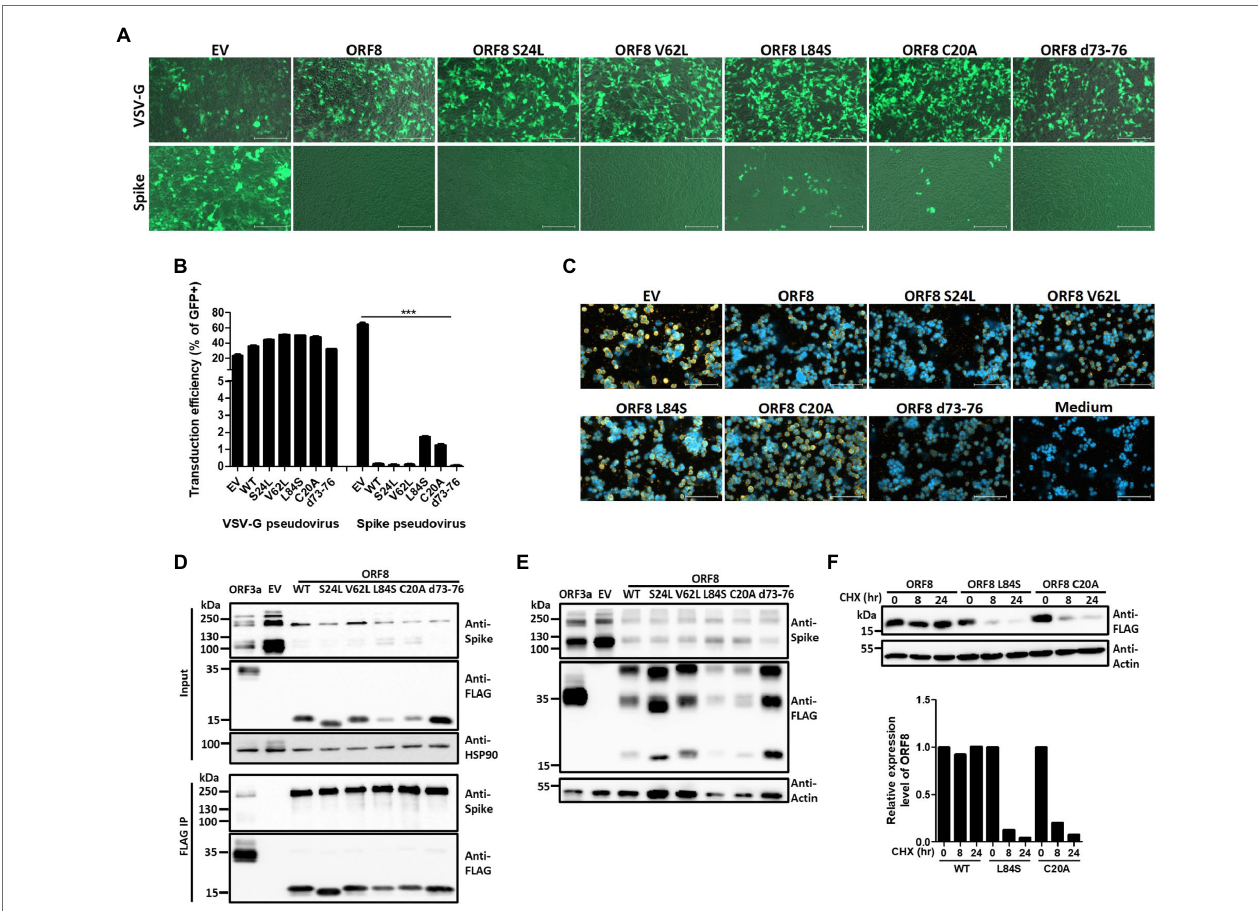
FIGURE 5 | Impact of ORF8 mutations on regulating the spike protein and their own stability. Spike or VSV-G pseudoviruses were produced using the pLAS2- IRES-GFP (EV) lentiviral vector or the same vector carrying different ORF8 mutants shown as mutation sites. After the purification of these pseudoviruses, an equal amount of viral supernatant was used to test their transduction efficiencies in HEK293T/hACE2 cells, which were observed as GFP-positive cells 4 days post- transduction and were (A) visualized by fluorescence microscopy and (B) quantified by flow cytometry. EV: empty vector; WT: wild type. (C) The relative quantity of Spike pseudoviruses in these samples was evaluated by a binding assay of HEK293T/hACE2 cells exposed to the same volume of different viral samples, and samples were then visualized with a polyclonal antibody recognizing the spike protein and a Cy3-conjugated secondary antibody. DAPI was used for staining nuclei. (D) Co-immunoprecipitation assays were performed using HEK293T cells cotransfected with spike-encoding plasmid together with pLAS2-based plasmid carrying different ORF8 mutants 3 days post-transfection. Here, a polyclonal antibody against the spike protein was used. (E) A set of Samples similar as (D) was prepared in non-denature condition and subjected to immunoblotting experiment. (F) A cycloheximide-tracing experiment was performed with cells transfected with a plasmid encoding wild-type ORF8, L84S, or C20A mutation. The transfected cells were treated with 100 μ g/ml cycloheximide at 24 h post-transfection. Immunoblots of the samples collected from the indicated time points after cycloheximide treatment were performed using an anti-FLAG antibody. Antibody against actin served as a control. The protein stability of each ORF8 mutant shown in was evaluated by comparing the protein amounts of ORF8 and actin quantified using the ImageJ software. The bar figure in (B) shows the means ± SDs (error bars). The unpaired Student’s t -test was used, and p < 0.05 indicates a statistically significant difference; *** p < 0.001. The figure shows the statistical analyses of the comparisons of EV vs. all ORF8 variants, WT vs. L84S, and WT vs. C20A. The scale bar in (A) represents 200 μ m and (C) represents 100 μ